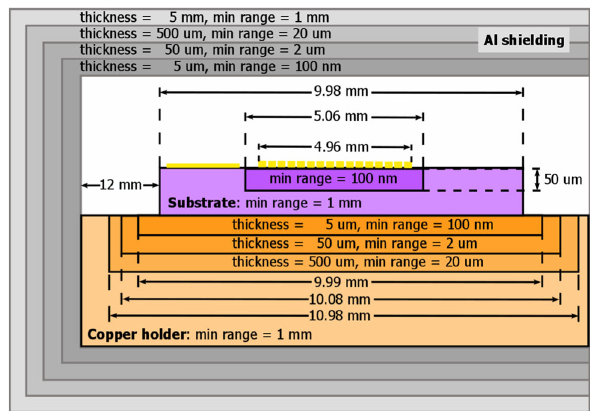
Fig. 3 Non-scaled scheme of the region around the ECHo-1k chip. The minimum ranges particles have to pass before getting absorbed in different layers of the larger volumes and their dimensions are shown. Picture taken from [12] The simulations are divided into two sets. If the